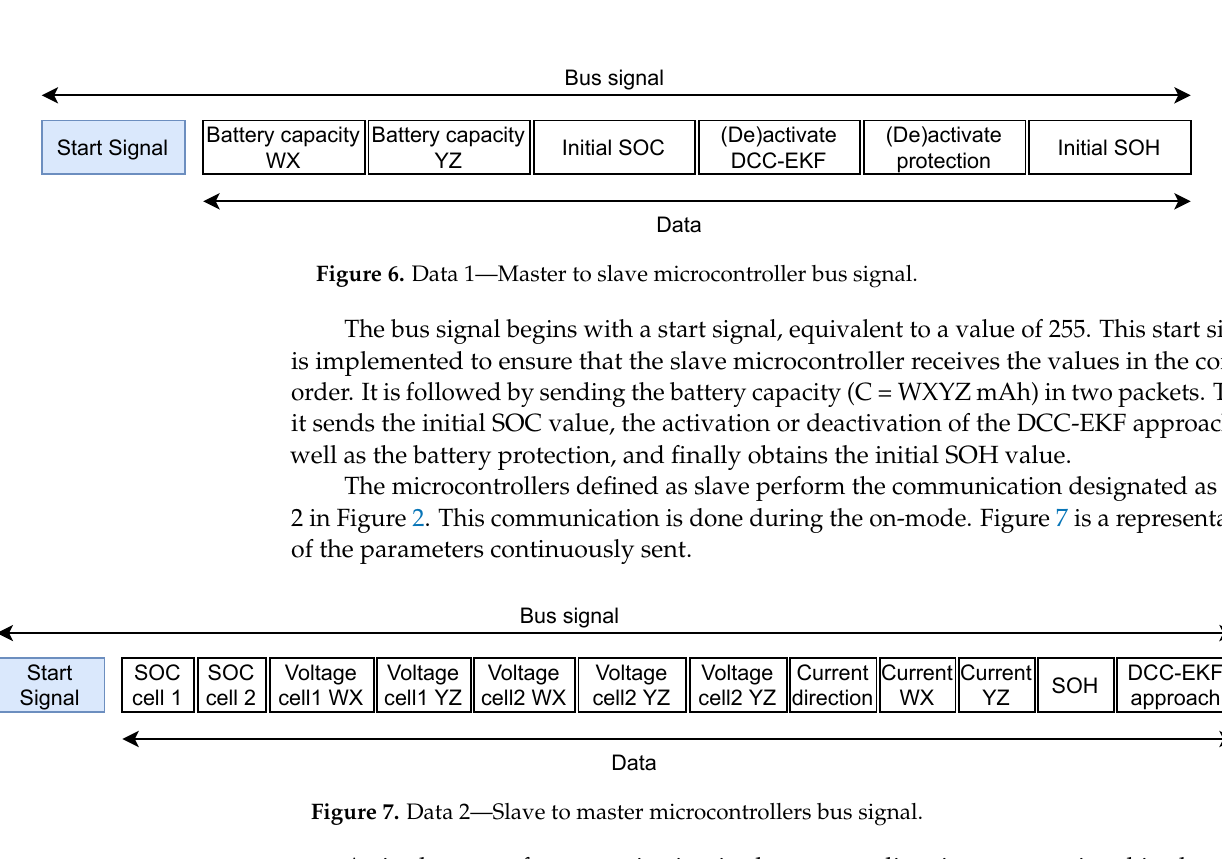
Figure 7. Data 2—Slave to master microcontrollers bus